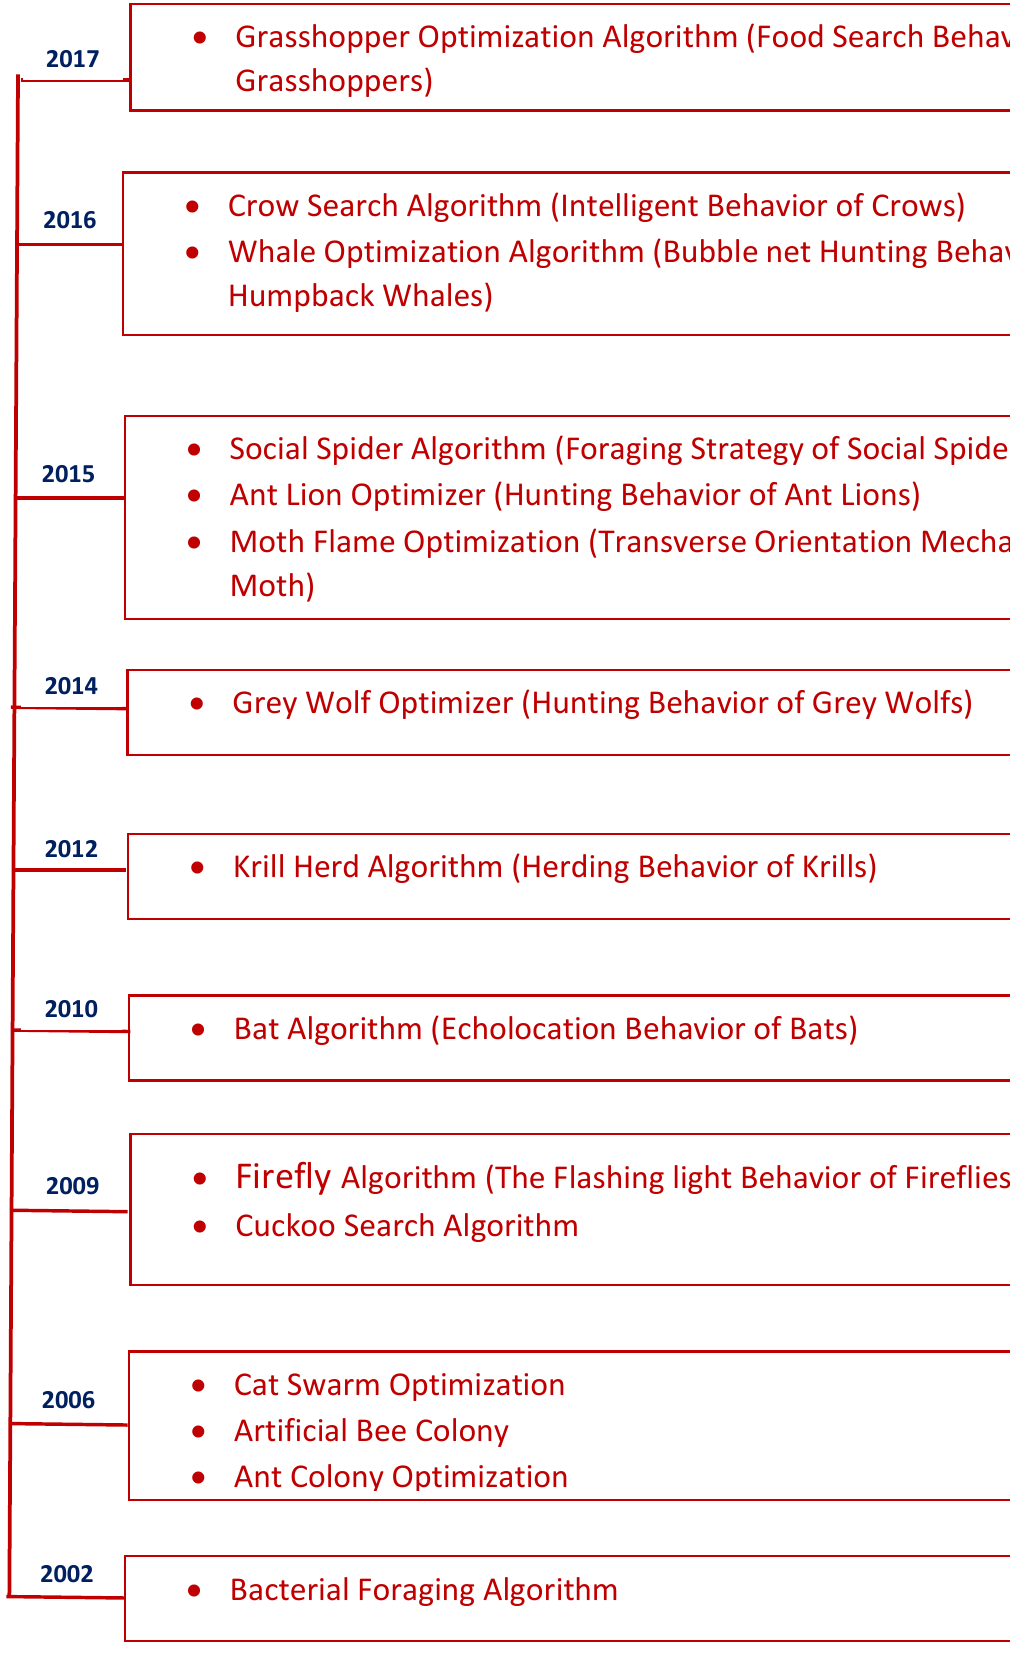
Figure 1. Development timeline of some of the leading bio-inspired